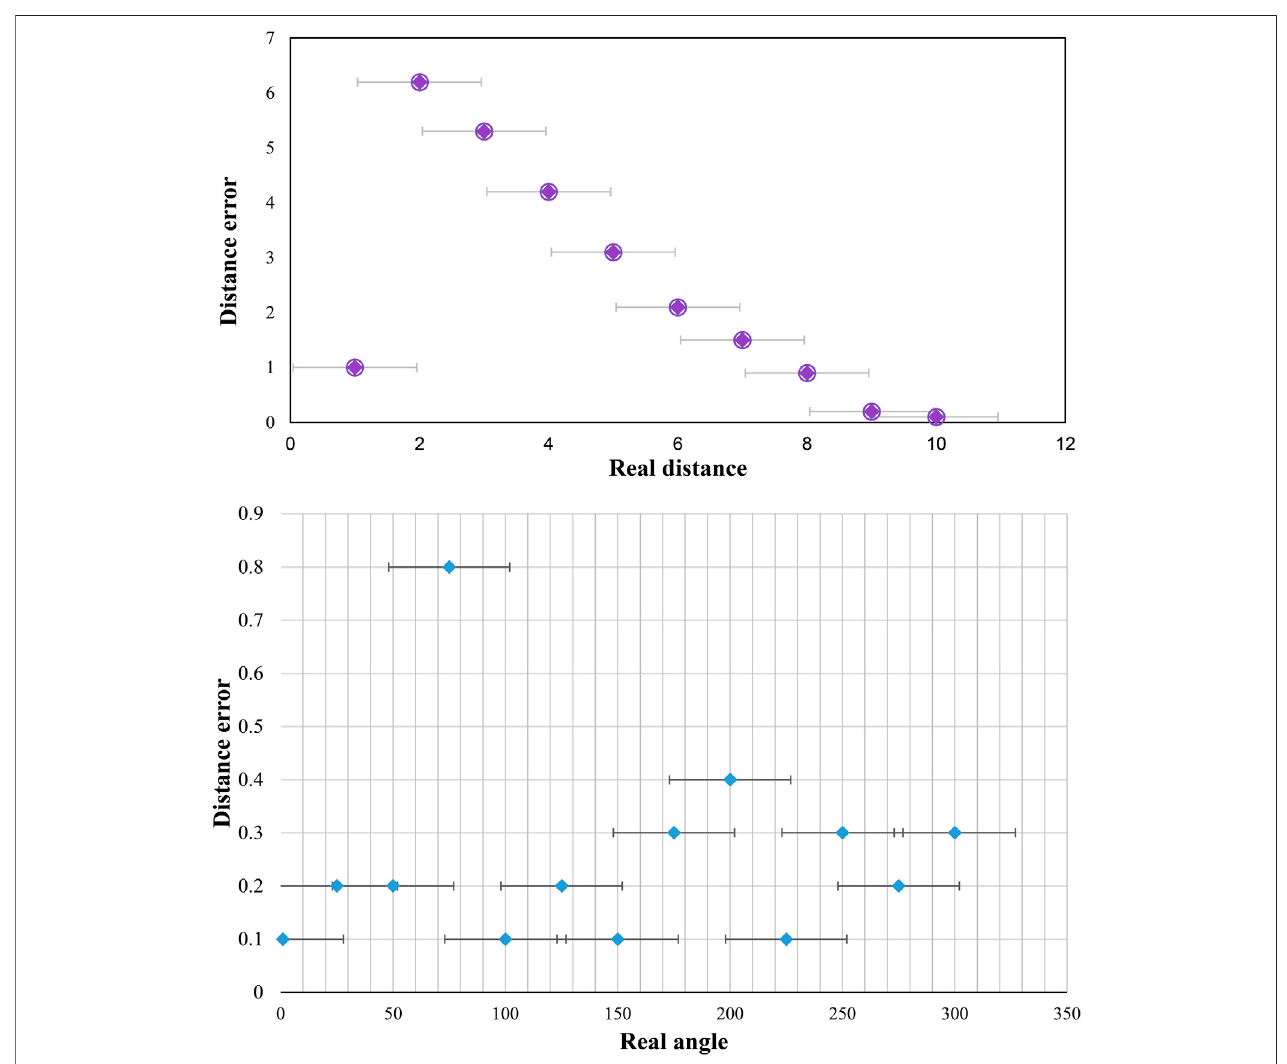
FIGURE 11 | Static distance and angle